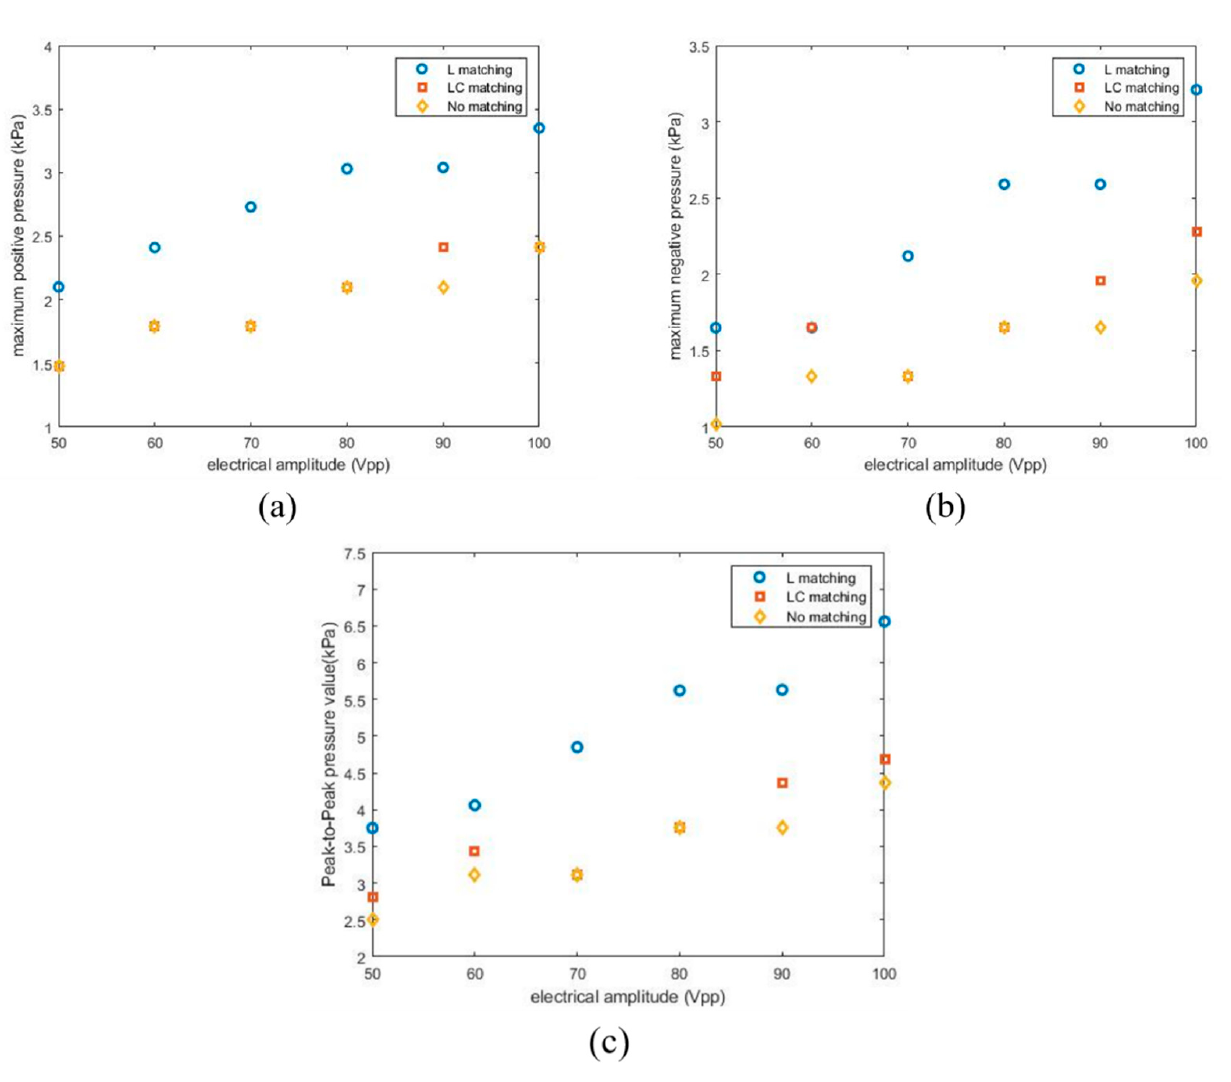
Figure 10. Measured pressure depending on excitation voltage. ( a ) Maximum positive pressure ( b ) absolute value of maximum negative pressure, ( c ) peak-to-peak pressure.